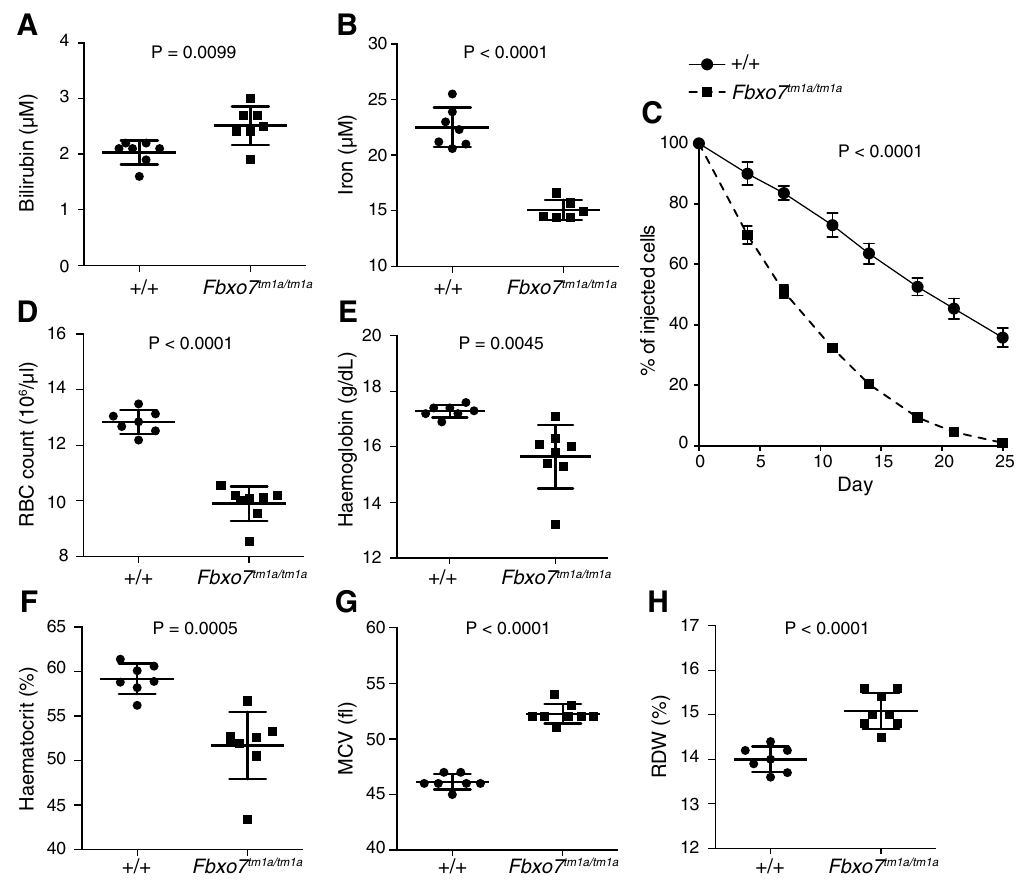
Fig 2. Anaemia in Fbxo7 targeted mice is regenerative with a shorter erythrocyte half-life that is haematopoietic intrinsic. (A) plasma bilirubin and (B) plasma iron from 15-17-week-old Fbxo7 +/+ and Fbxo7 tm1a/tm1a female mice. (C) In vivo half-life of Fbxo7 +/+ and Fbxo7 tm1a/tm1a erythrocytes, the P value indicated is for each time point. D-H) characterisation of erythrocyte indices from Fbxo7 +/+ and Fbxo7 tm1a/tm1a bone marrow chimeras 10 weeks after reconstitution (female recipient mice). All data representative of three independent experiments, each symbol represents an individual mouse with the line at the mean and error bars represent standard deviation, except for (C) where n = 6 for Fbxo7 +/+ and Fbxo7 tm1a/tm1a with mean ± standard error of the mean. P values from an unpaired two-tailed students t test with Welch’s correction (A, B, D-H) or C two-way repeated measures ANOVA with Sidak post-hoc test for individual time points.